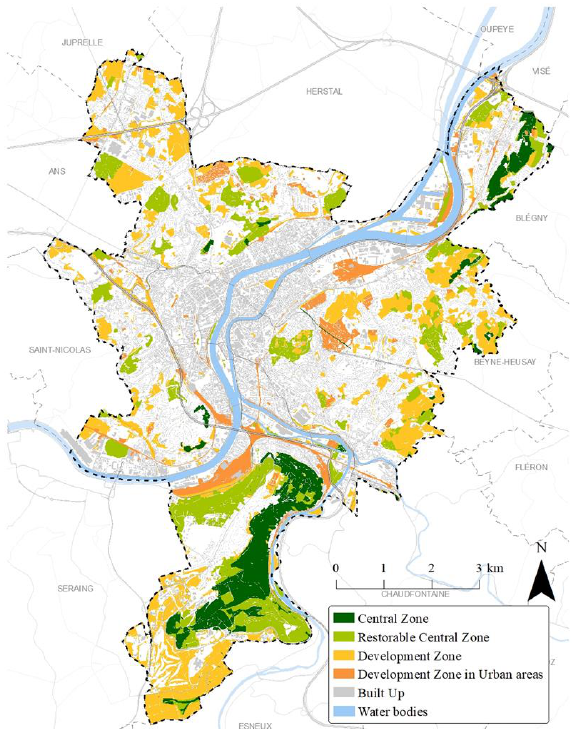
Figure 2. Zones in ecological network of Liege along with built-up (Source - ecological network: PCDN de la Ville de Liège, IGN-Top10v et Smartpop) As green roofs are observed to have ecosystems similar to dry lawns and meadows (not frequently), we consider only these two environments in our analysis. We also consider potential roofs with greater than 100 square meter area. We calculate the distance between the potential green roofs and the distance between ecological network zones (dry lawns and meadows environment) and potential green roofs. This was done using near distance tool in ArcGIS Pro 2.7. We consider bees